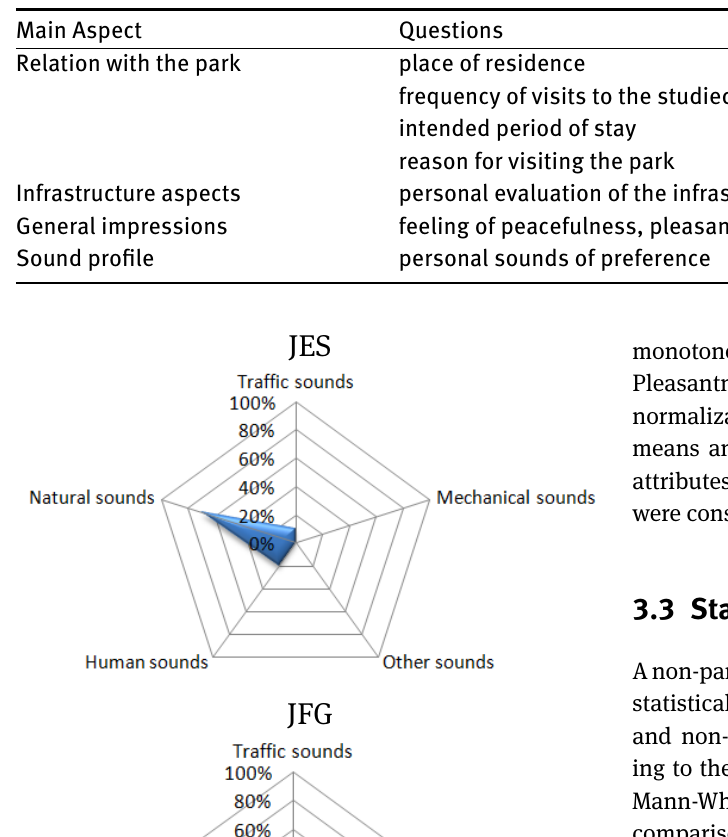
Table 1: Main aspects and questions applied in in situ tests.